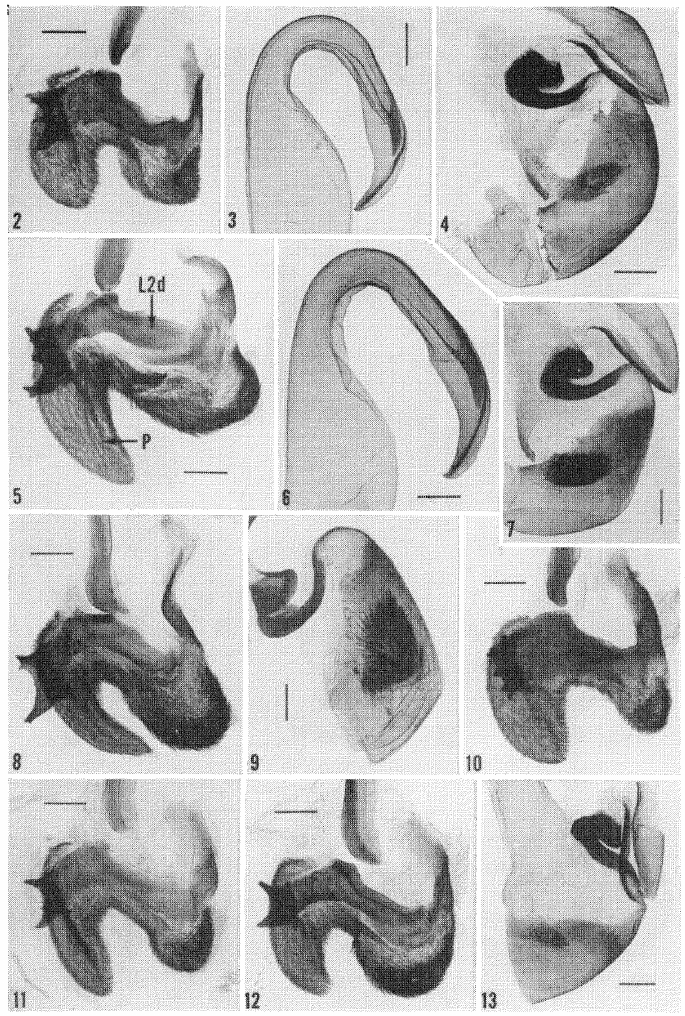
Figs. 2-13. Cockroach male genitalia. Epilanpra mexicana. 2-4. (63 USNM). Guatemala. 5-7. (109 USNM). Turrialba, Costa Rica. 8-9. (106 USNM). Turrialba, Costa Rica. 10. (111 USNM). Chis. Soyalo, [Rt. 195, Km 24], Mexico. (2-10, det. Gurney). 11. (52 ANSP). Central Mexico.. 12-13. (110 USNM). Ver. Rio Tacolopan, [Rt. 195, Km 24], Mexico. (11-13 det. Roth). (L2d dorsal sclerite of L2; P prepuce). (scale 0.2